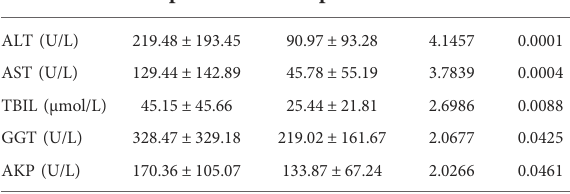
TABLE 3 Preoperative and postoperative biochemical characteristics of the